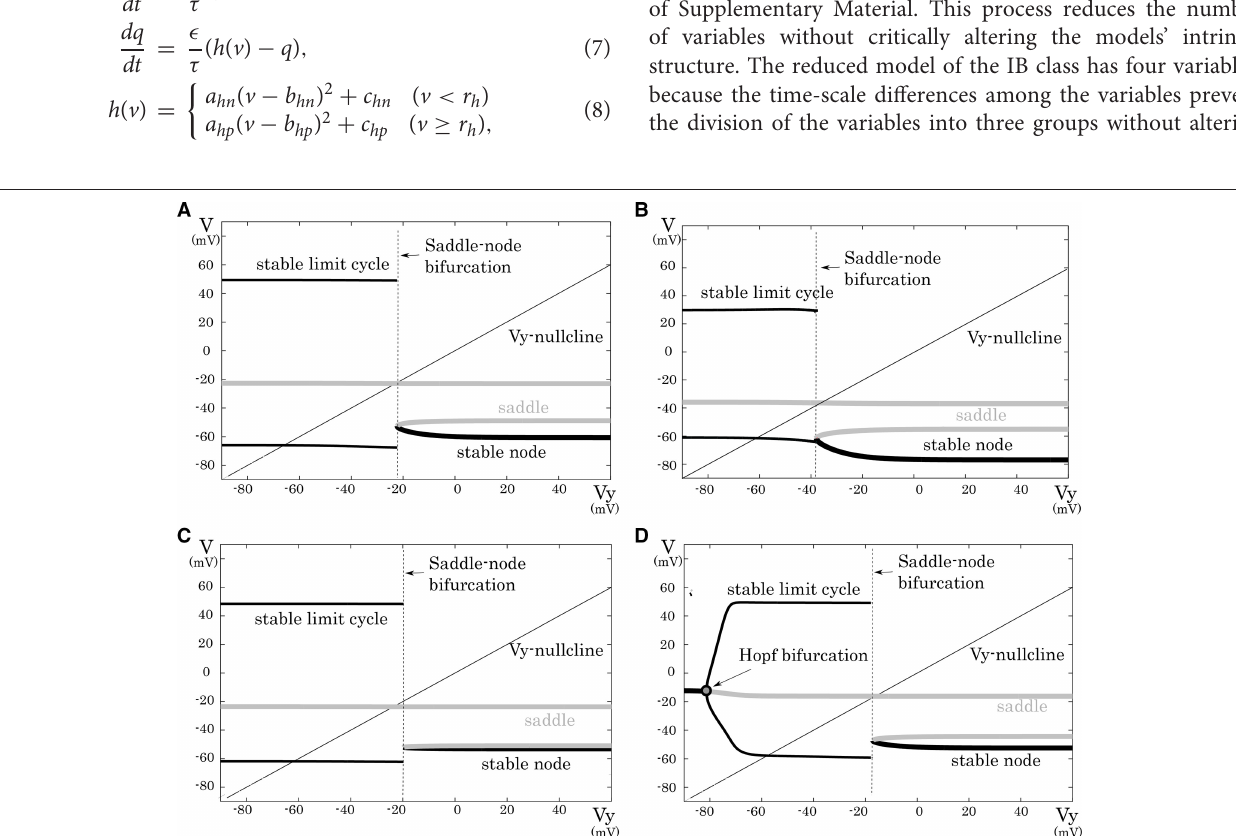
FIGURE 3 | Mathematical structures of the reduced models. Projected mathematical structures onto the V y − V plane. A stimulus sufficiently strong for periodic spiking is applied. The saddle-node bifurcation is observed in (A) the excitatory RS, (B) the inhibitory RS, (C) the FS, and (D) the LTS classes.